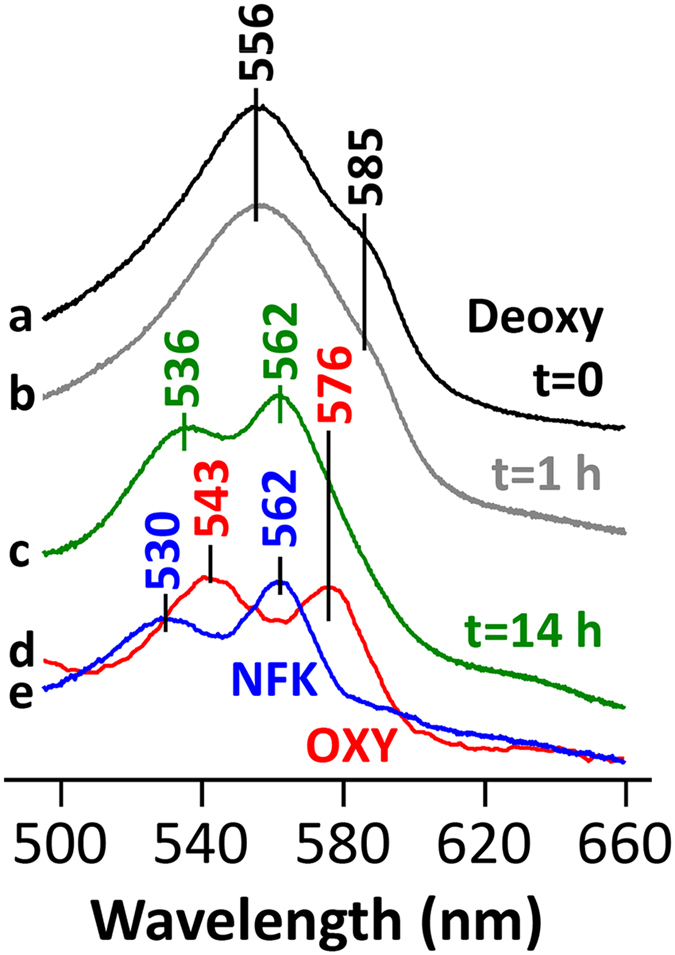
Absorption spectra of hTDO oxygen intermediates.(a) Spectrum of a ferrous hTDO crystal in complex with L-Trp, before exposure to O2-saturated solution (black). The spectrum has a band at 556 nm and a shoulder at ~585 nm, which is characteristic for a five-coordinate high spin heme. (b) Spectrum of the same ferrous hTDO crystal in complex with L-Trp, after 1h exposure to O2 (gray). (c) Spectrum of the same ferrous hTDO crystal in complex with L-Trp, after overnight exposure to O2 (~14 h) (green), with two bands at 536 and 562 nm, indicating the formation of an oxygen intermediate. (d) Typical spectrum of the hTDO-Trp-O2 ternary complex obtained by mixing of ferrous hTDO-Trp with air-saturated solution in a stopped-flow system (red). (e) Difference spectrum, (c,d) which likely represents the spectrum of NFK-bound ferrous hTDO (blue). The double peak feature of this spectrum indicates a six-coordinate low spin heme, consistent with the crystallographic observation that NFK is coordinated to the heme iron via its formyl group as the 6th ligand. This spectrum cannot be obtained by mixing hTDO and NFK due to the transient nature of this complex.